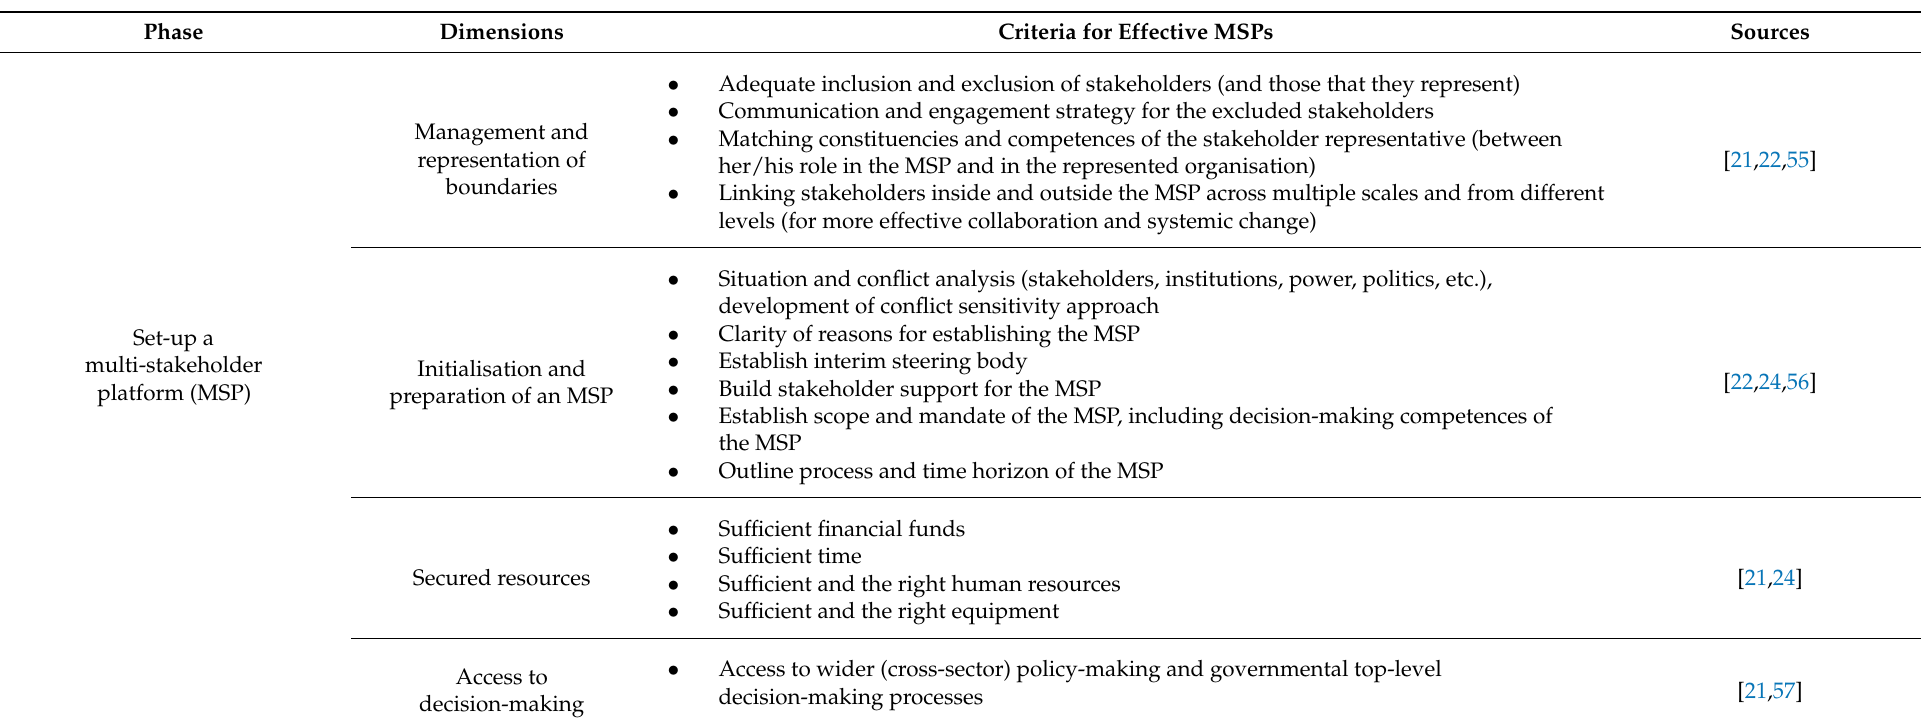
Table 2. Analytical